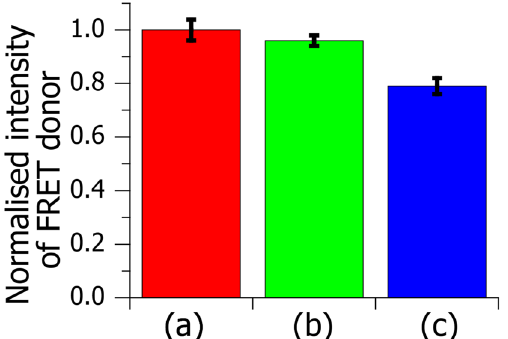
Figure 1. FRET-quenching intensity of the donor in wet and dehydrated DOPC monolayers. The samples contain 0.2 mol% Bodipy-PC and 0.4 mol% Texas Red labelled DPPE (Texas Red-DPPE) as FRET donor and acceptor, respectively. Bars show the donor intensity I donor of ( a ) a wet sample, ( b ) a sample dehydrated by the RFS method and ( c ) a sample dehydrated at the atmospheric pressure and room temperature. For easy comparison, the I donor -values of the dehydrated samples were normalised to that of the wet sample. Error bars indicate the standard